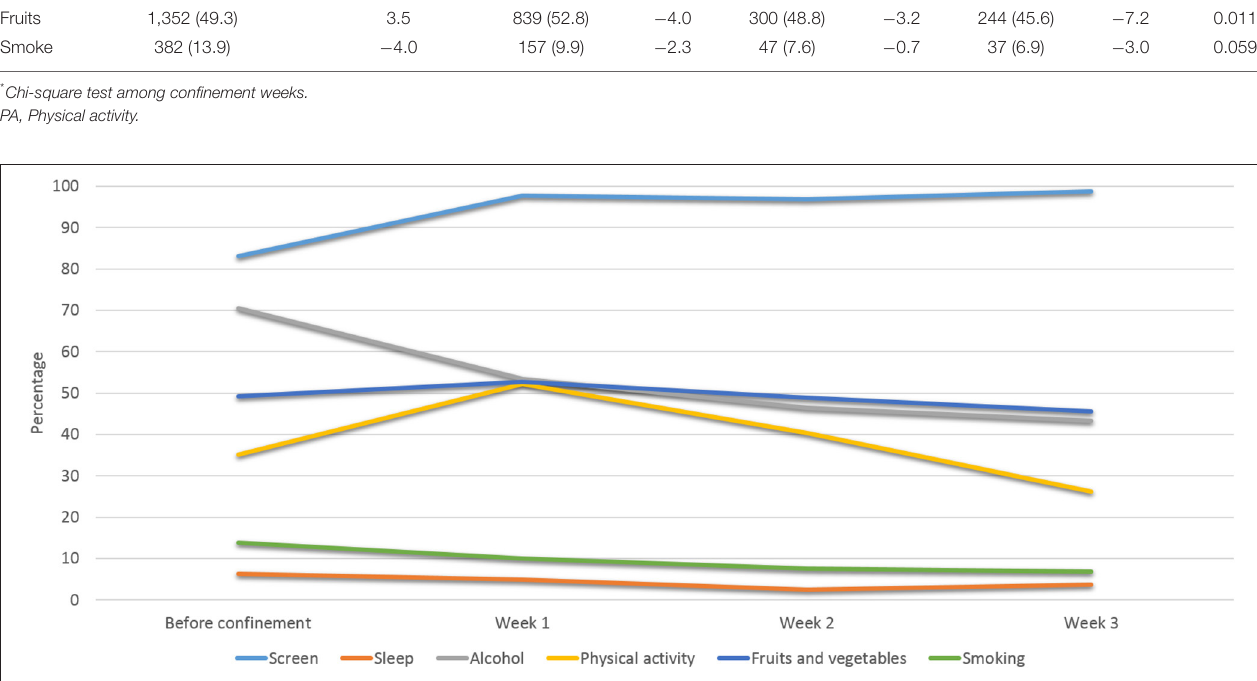
adjusted, both subgroups present significant associations, with, respectively, OR 0.44; 95% CI: 0.20–0.99 and OR 0.55; 95% CI: